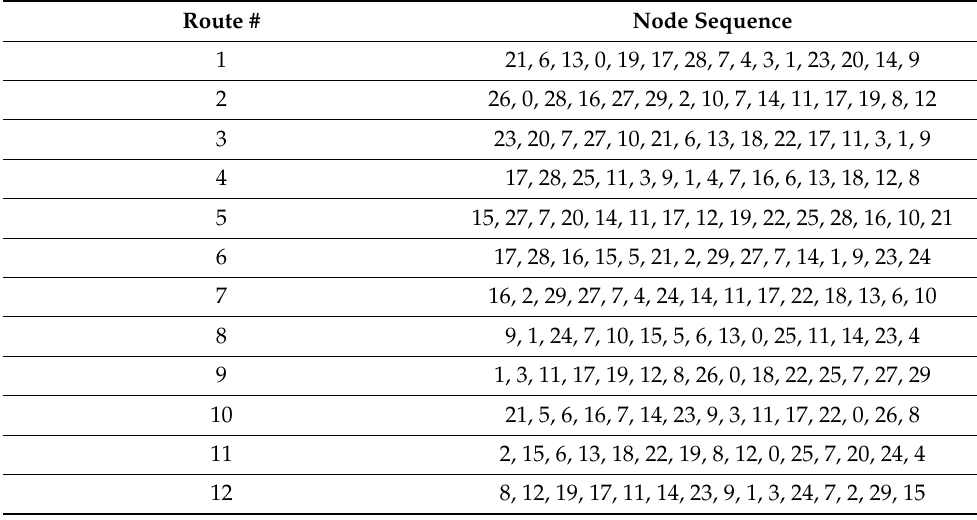
Table 10. Best route set for Mumford0. Route